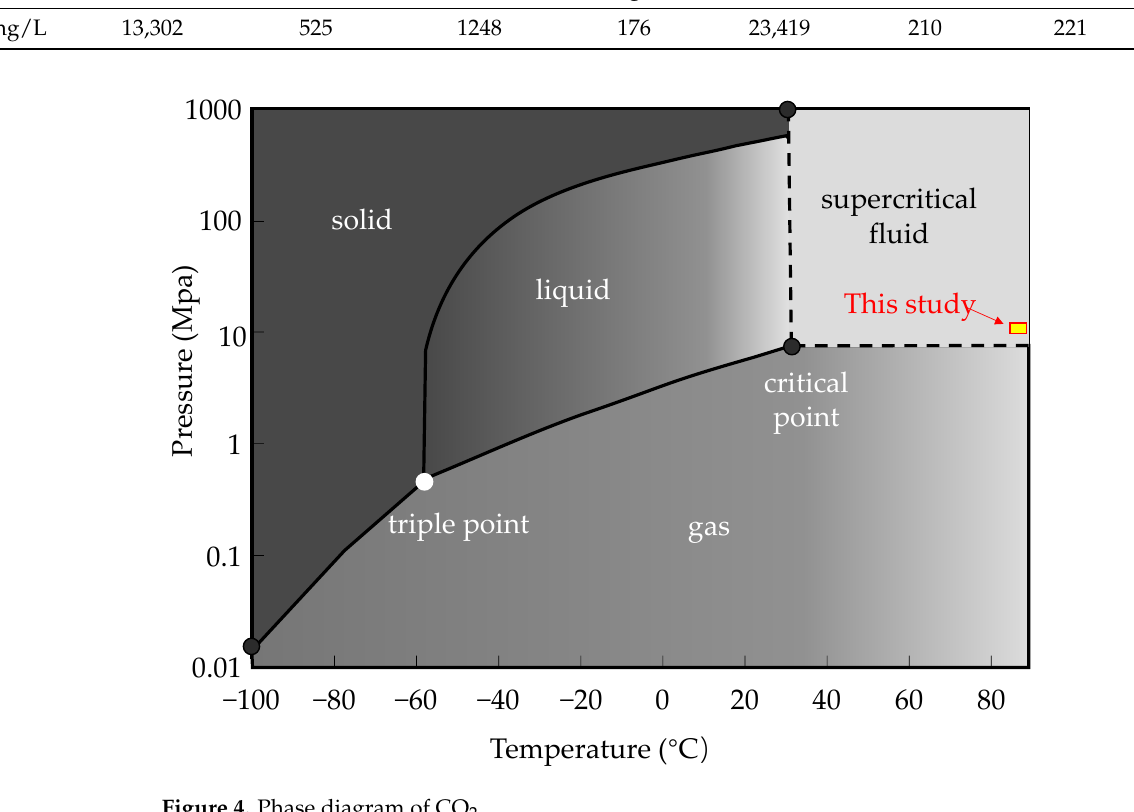
Figure 3. Clay mineral analyses of C7 and S1 shales.